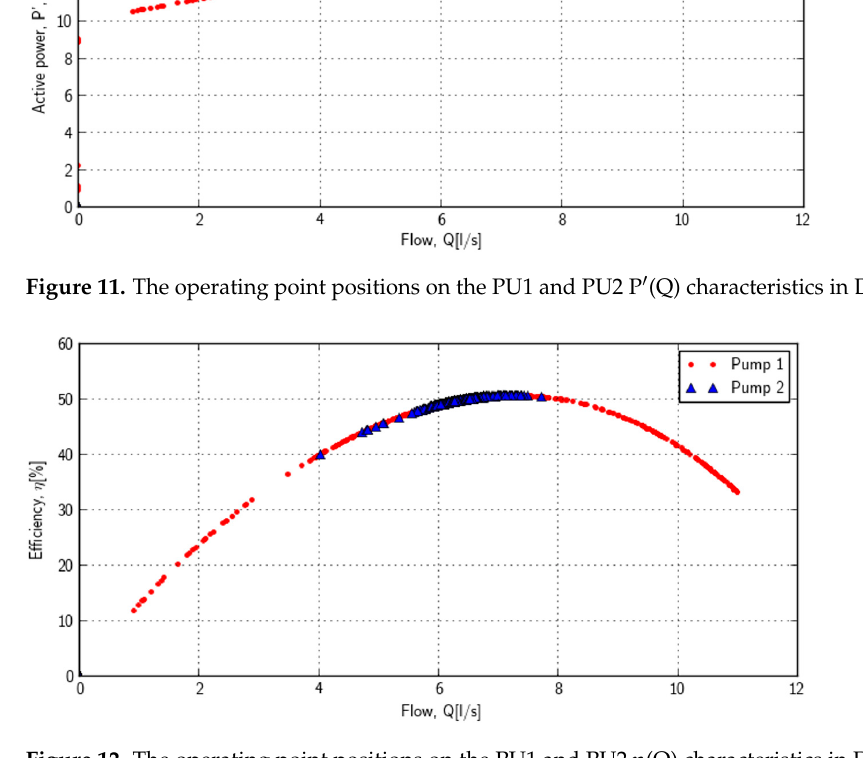
Figure 12. The operating point positions on the PU1 and PU2 η (Q) characteristics in December 2009 .